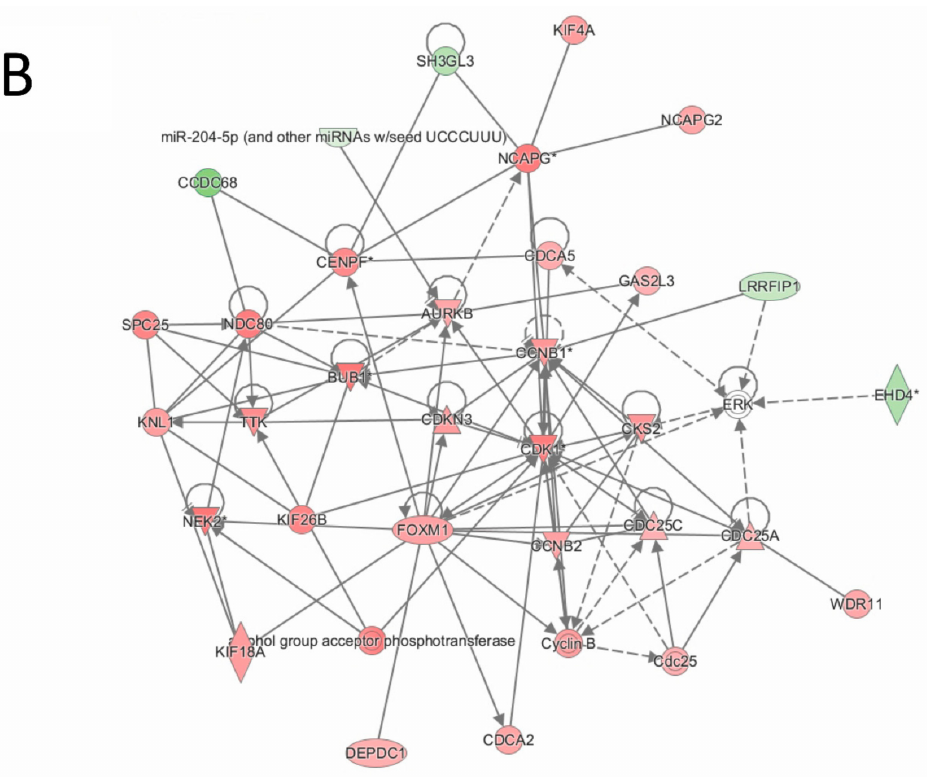
Figure 4. Ingenuity Pathway Analysis indicates the relation between genes di ff erentially expressed between imatinib-naïve (IM-n) and imatinib-resistant (IM-r) gastrointestinal stromal tumor (GIST) samples. The 352 significant di ff erentially expressed genes between IM-r and IM-n GIST samples were used as input for an Ingenuity Pathway Analysis (IPA). The depicted IPA networks illustrate and visualize associations between the genes. ( A ) IPA network highlighting cell cycle related, di ff erentially expressed genes. ( B ) IPA network highlighting CDK1, AURKB, and FOXM1 interactions. Green and red shading indicates relatively low and high expression in the IM-r samples. See Table S5 for an extended symbol